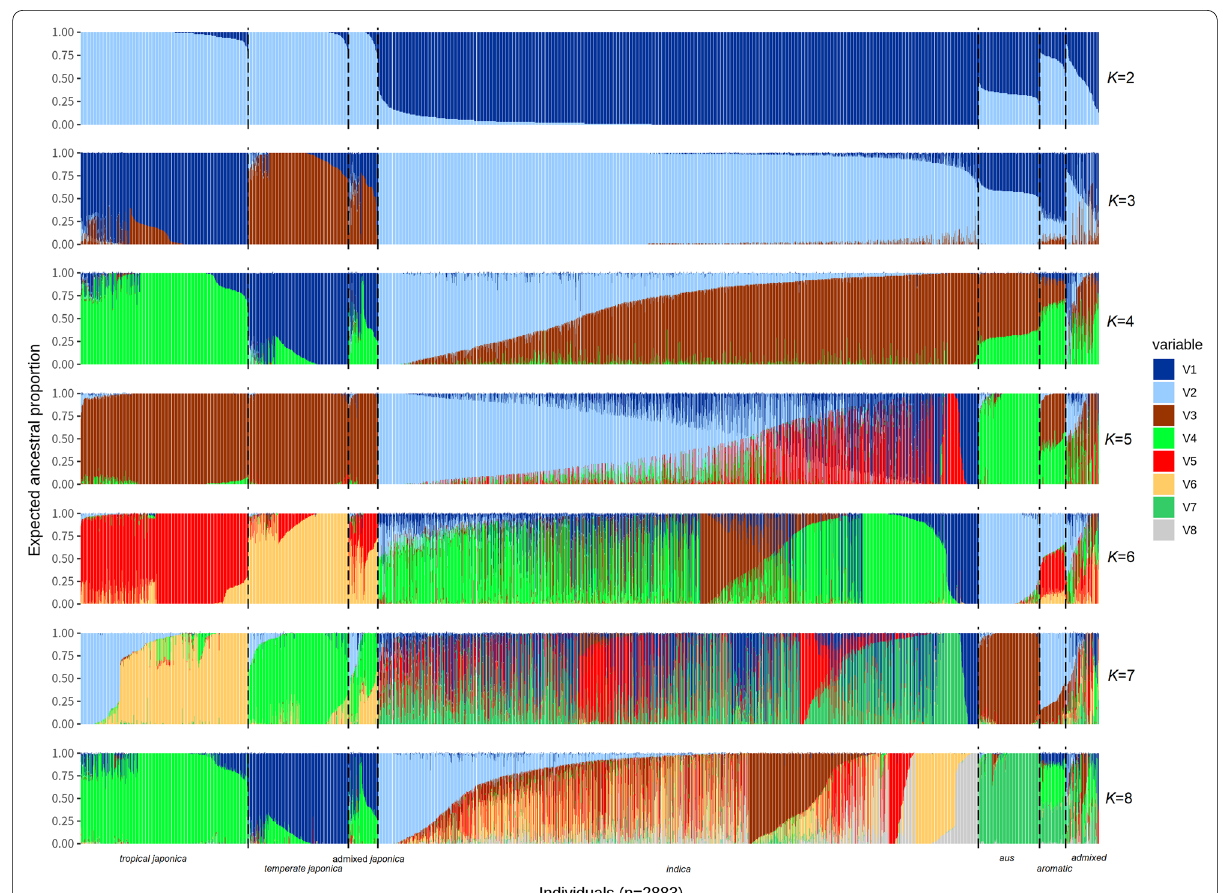
Fig. 3 Model‑based population structure at K